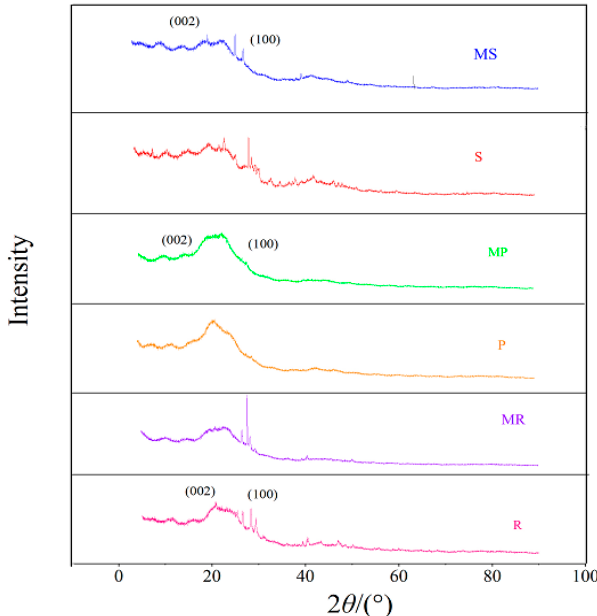
Figure 4. XRD patterns of the pristine and Fe-modified biochar.